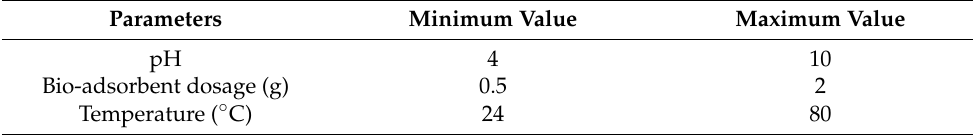
Table 1. Factors’ range.